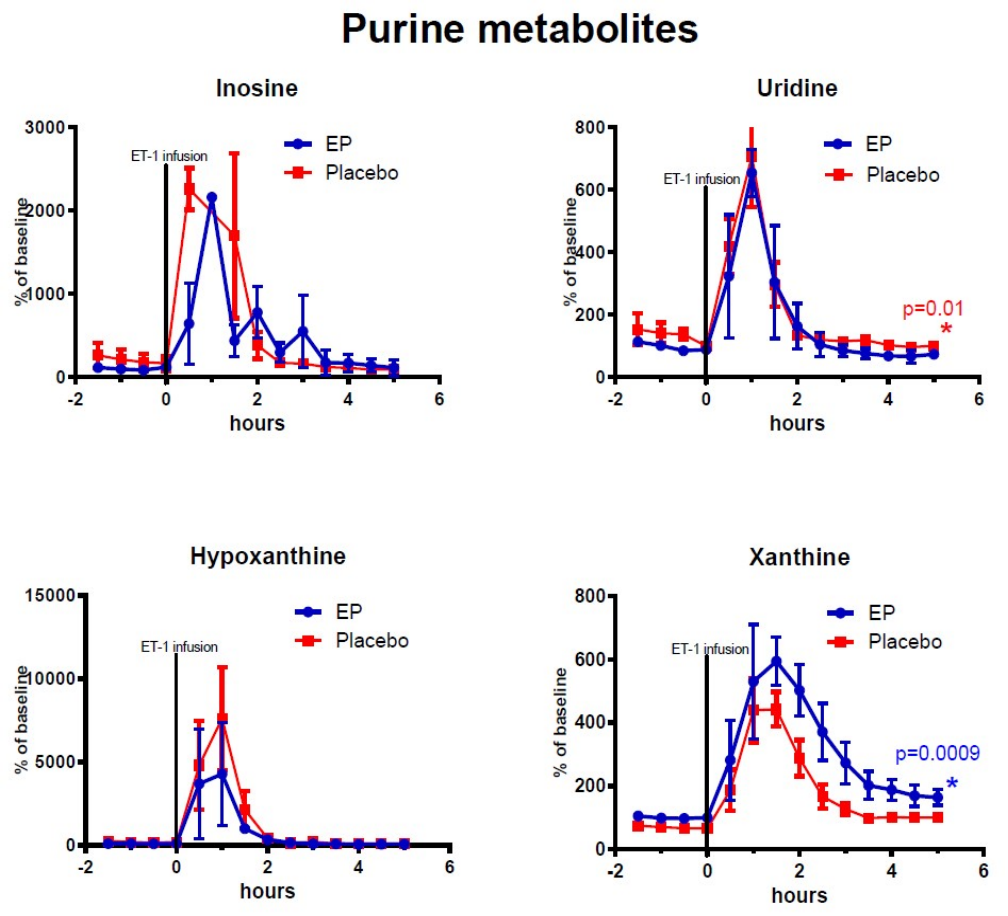
Figure 4. Changes of endogenous (non-labeled) purine metabolites in ipsilateral striatum after ethyl pyruvate (EP) and placebo treatment. Vasoconstriction of the medial cerebral artery (MCA) was induced by ET-1 infusion in the piriform cortex (150 pmol/15 µL/15 min) starting at time = 0 h. Blue symbols and line indicate data for rats treated with EP immediately after ET-1 infusion ( n = 5). Red symbols and line indicate data for control rats (placebo treatment after ET-1, n = 6). Metabolite data are expressed as mean ± SEM of percentage change of each rat’s own baseline.